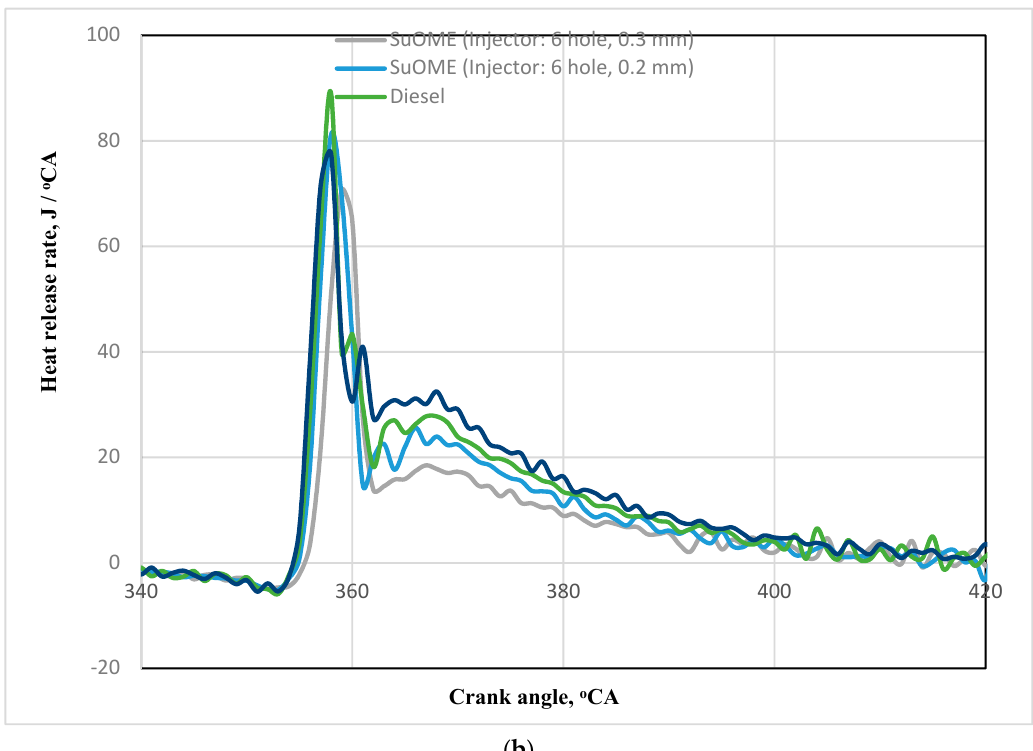
Figure 7. Variations of ( a ) in-cylinder pressure and ( b ) HRR with crank angle.